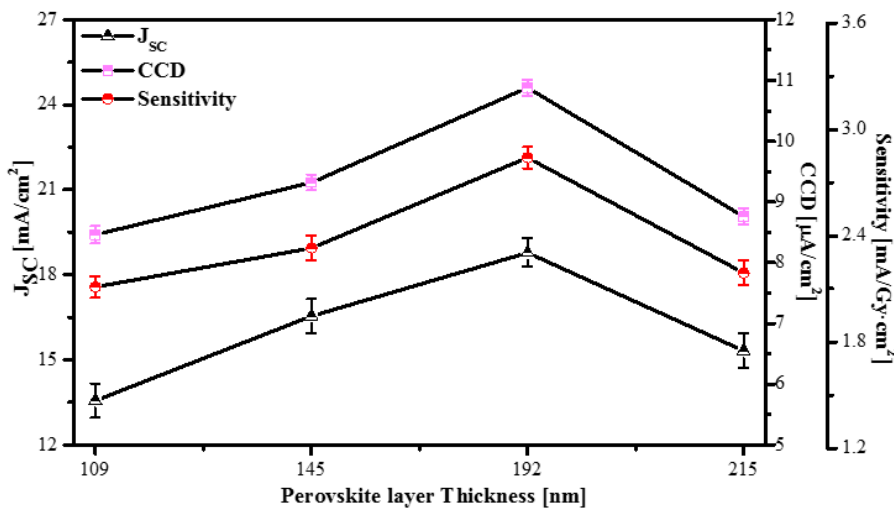
Figure 9. J SC , CCD, and sensitivity of the detector based on MAPbI 3 layer with different thicknesses at an annealing temperature 100 °C. Error bars represent the standard deviation based on 10 devices per condition.